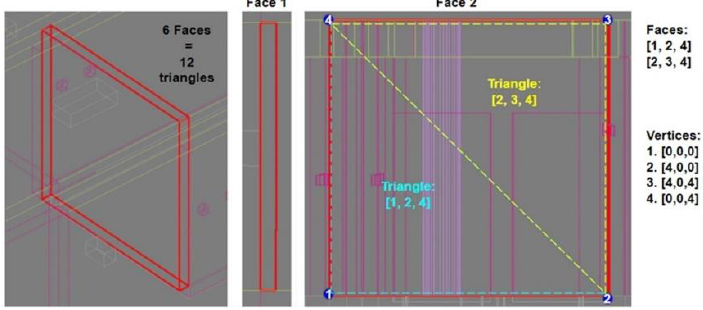
Figure 9. IFC object faces by